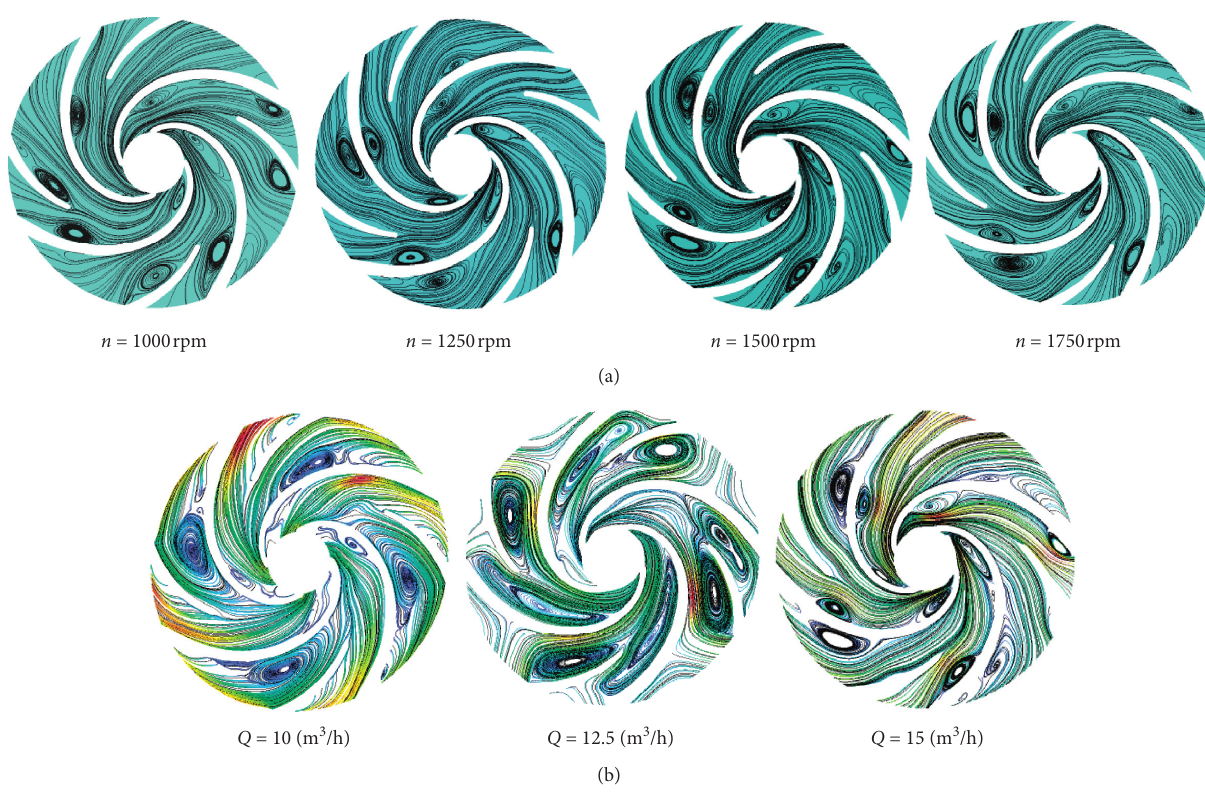
Figure 7: (a) Streamline vortex dissemination for Pump as Turbine at different speed level at BEP . (b) Streamline vortex dissemination for Pump as Turbine at different flow rate n �